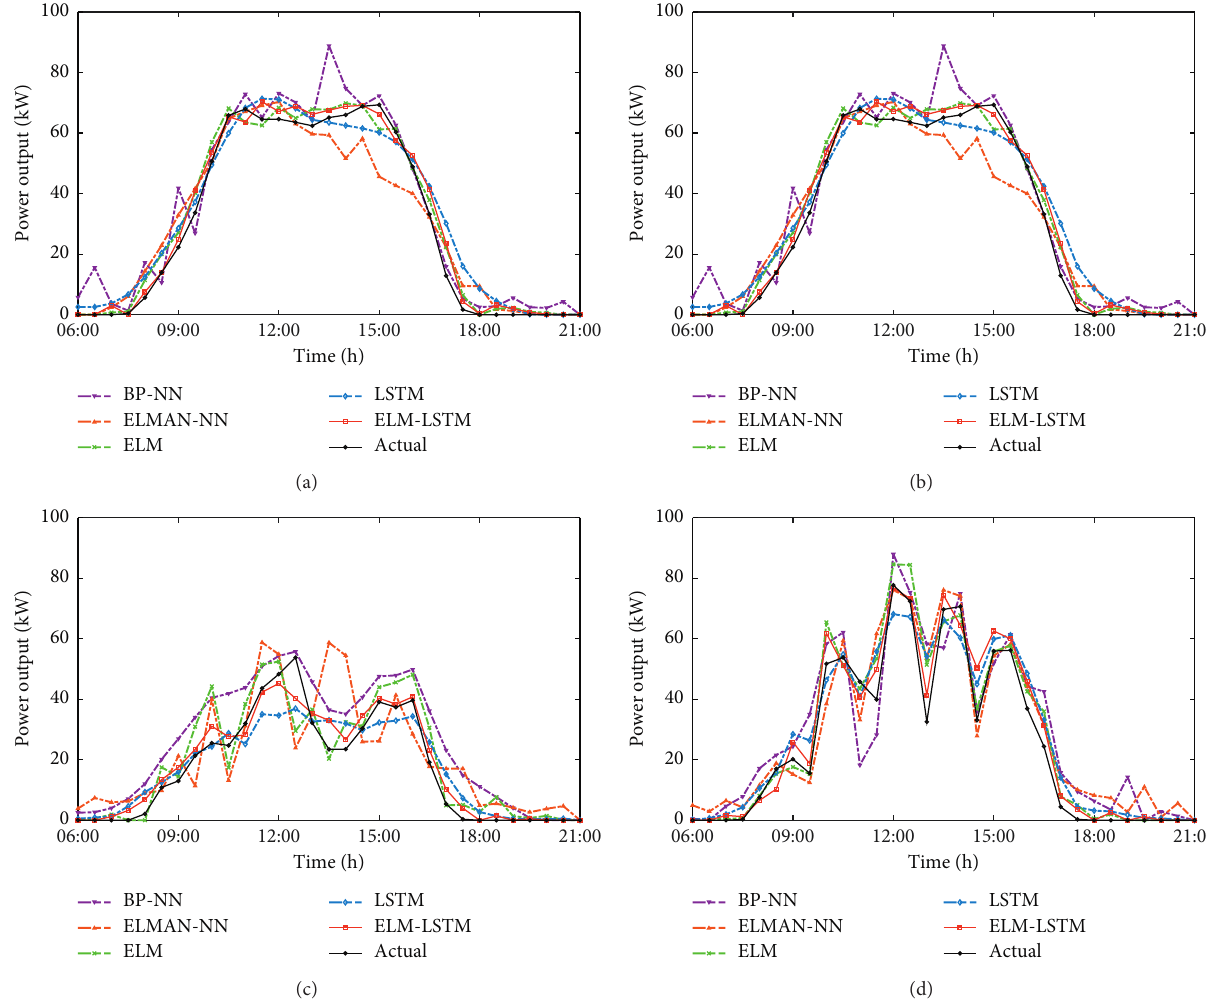
Figure 9: PV power output results of different forecasting models in different cases: (a) case 1, sunny day, (b) case 2, cloudy day, (c) case 3, cloudy and rainy day, and (d) case 4, day with large weather